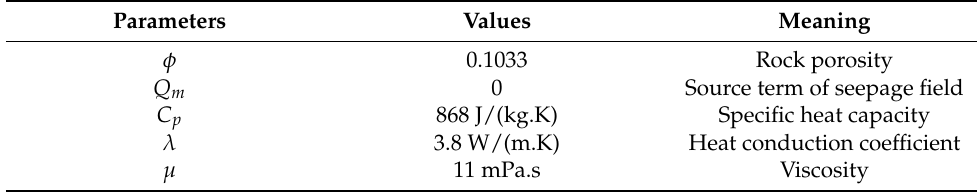
Table 2. Parameters for solving equations.